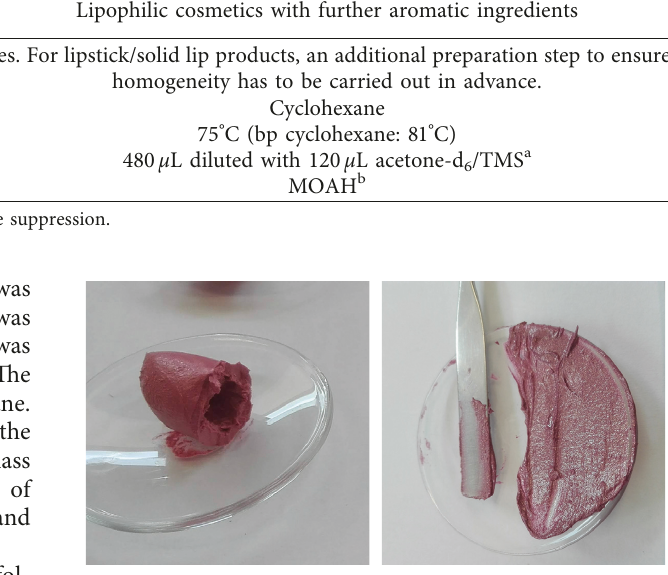
Figure 1: Additional preparation step for lipstick. (a) Removal from the lipstick; (b) filled with a spatula to homogeneity. Table 4: Creation of the validation series samples.